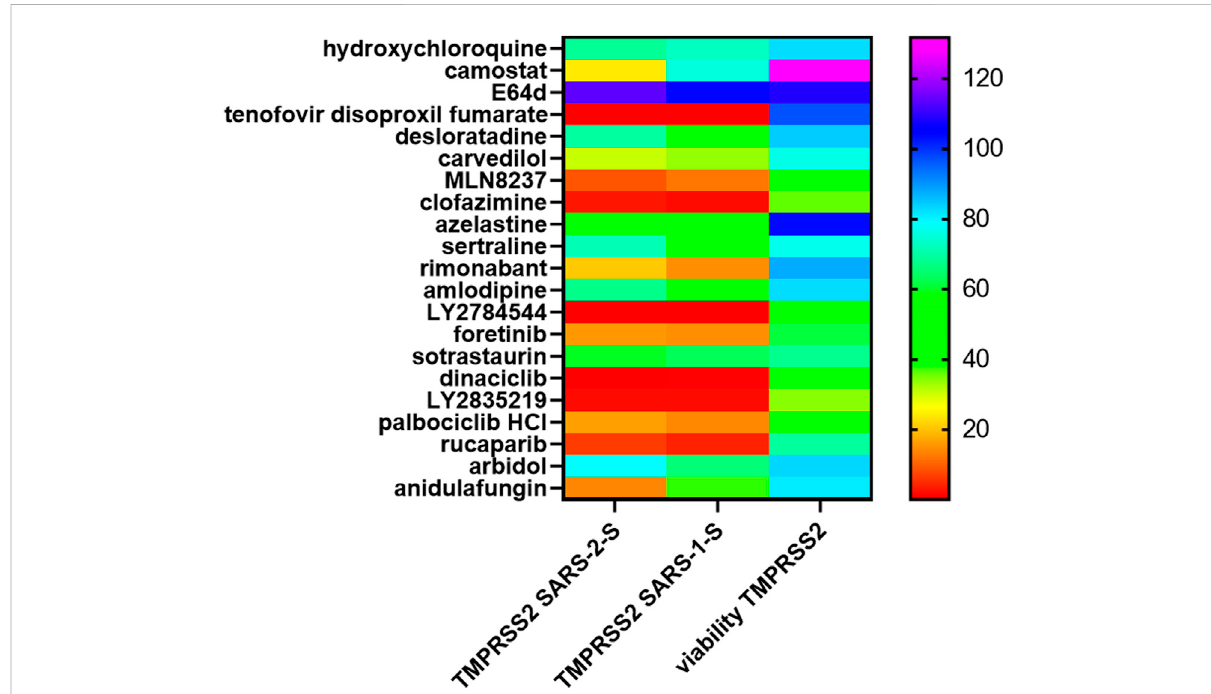
FIGURE 10 Rimonabant, rucaparib, carvedilol and anidulafungin inhibit SARS-CoV-2 infection of TMPRSS2 cells. Mouse leukaemia virus pseudotyped with the spike protein (S) from severe acute respiratory syndrome coronavirus (SARS-1-S) and SARS-CoV-2 (SARS-2-S) was used to infect 293T-ACE2- TMPRSS2 cells, in a 96-well plate for 48 h in the presence of the drug, as indicated, with 1 h pre-treatment. Infectivity was measured as luciferase activity and expressed as % infectivity versus infected, solvent control. Viability was measured by XTT assays in un-infected samples and expressed as % viability versus solvent control. Data are presented as a heat map of the mean of three